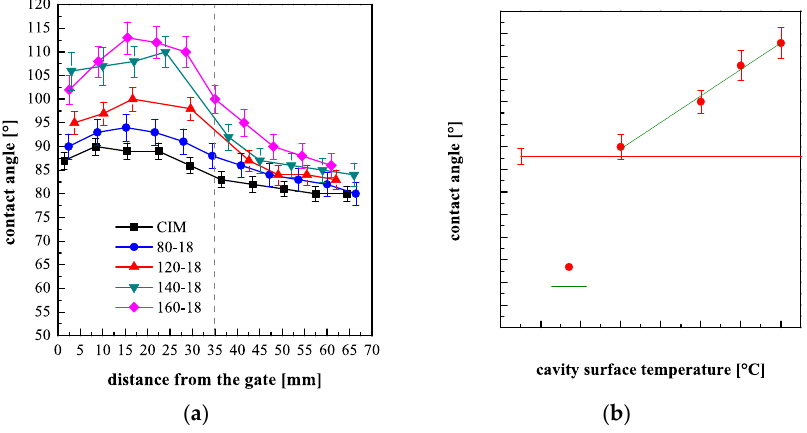
Figure 4. ( a ) Contact angles of the molded samples obtained with CIM and different T level , keeping active the heating devices for 18 s. The vertical dashed line identifies the location of the heating element; ( b ) Contact angle dependence on the cavity surface temperature (the contact angles were measured at 20 mm distance from the gate on the samples obtained with 18 s heating time).